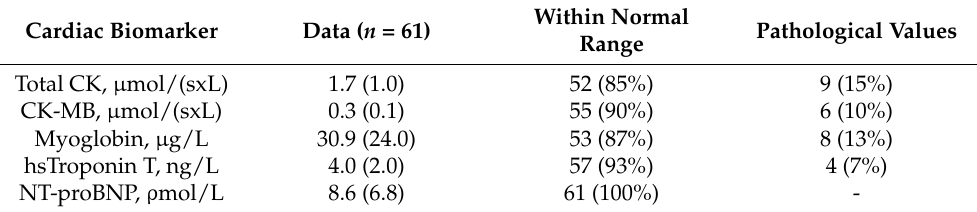
Table 4. Cardiac biomarker levels of Wilson’s disease